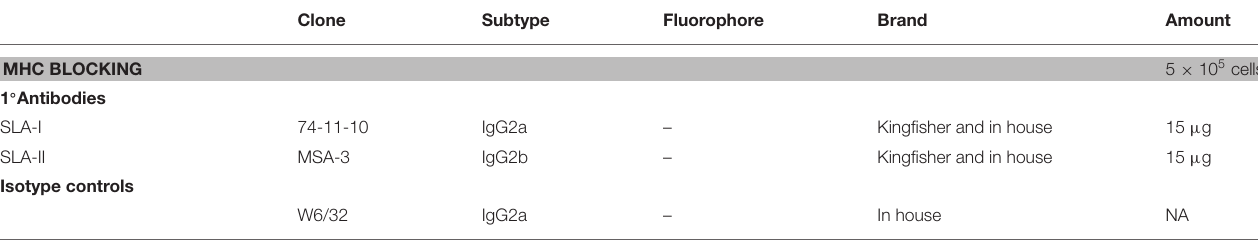
TABLE 3 | Immunological